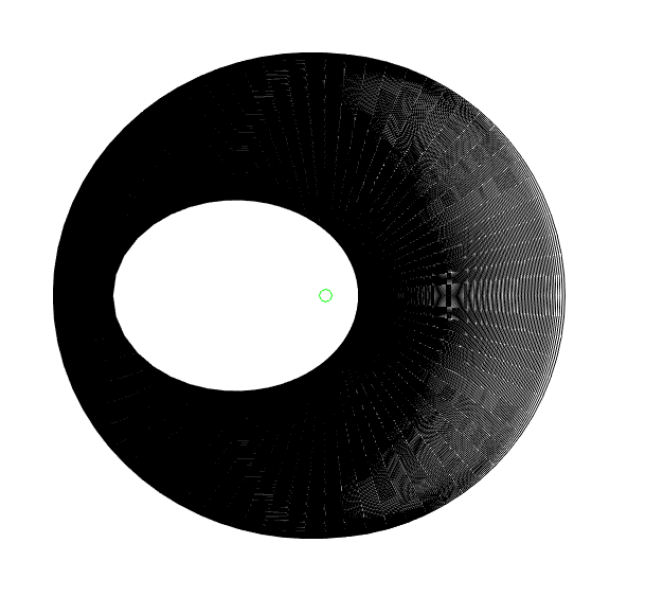
Figure 1. A 225-revolution, 156-day low-thrust orbit-raising maneuver from GTO to